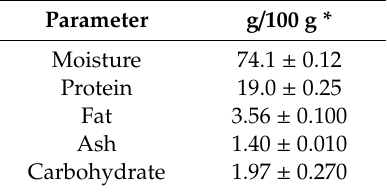
Table 1. Chemical composition of porcine liver. Results expressed as mean ± standard